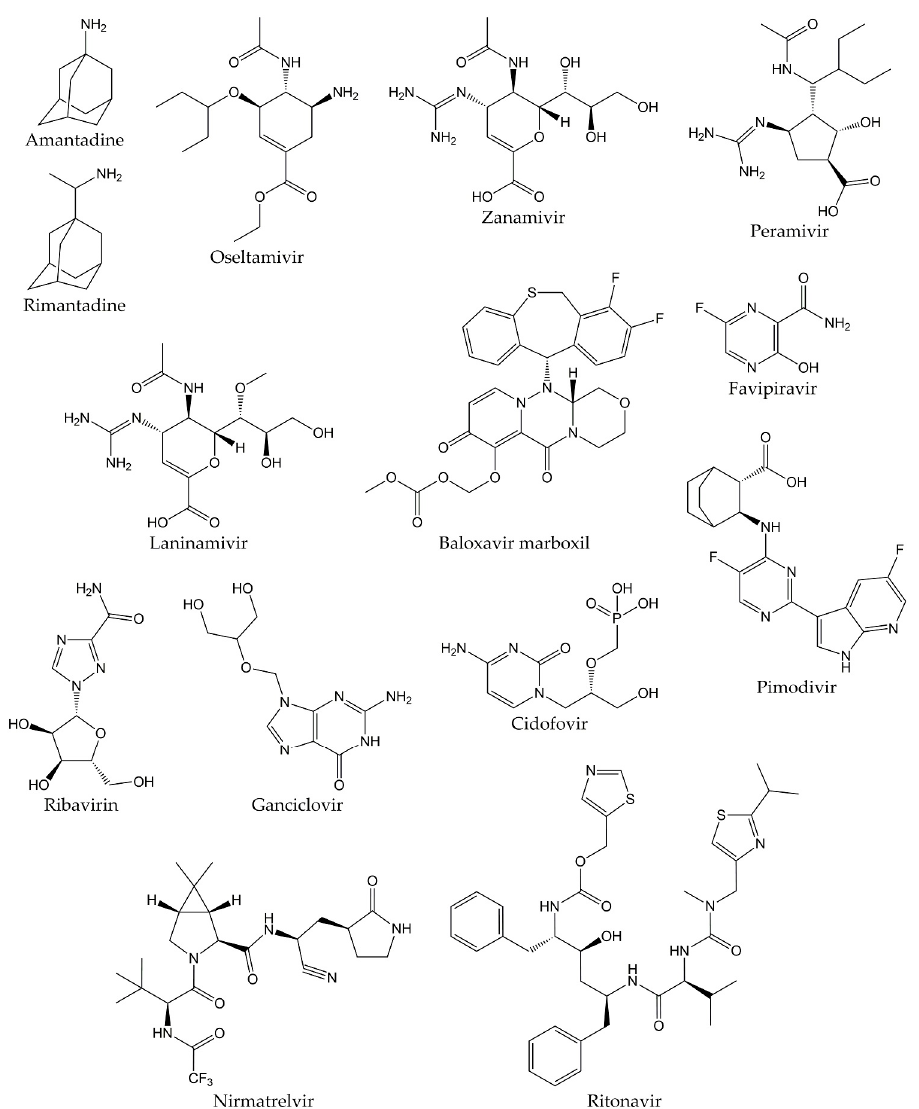
Figure 1. Chemical structures of antivirals against respiratory viruses.